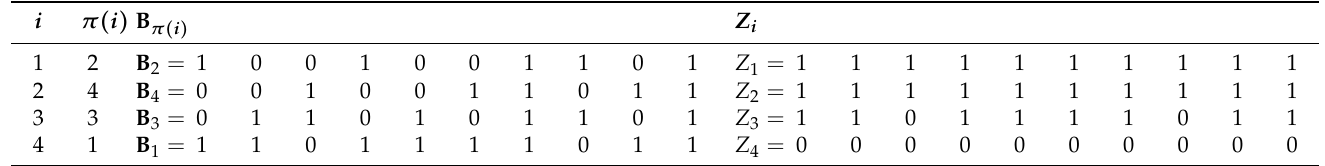
Table 5. Sorted B s for the example dataset D of Table 3 and the corresponding Z i